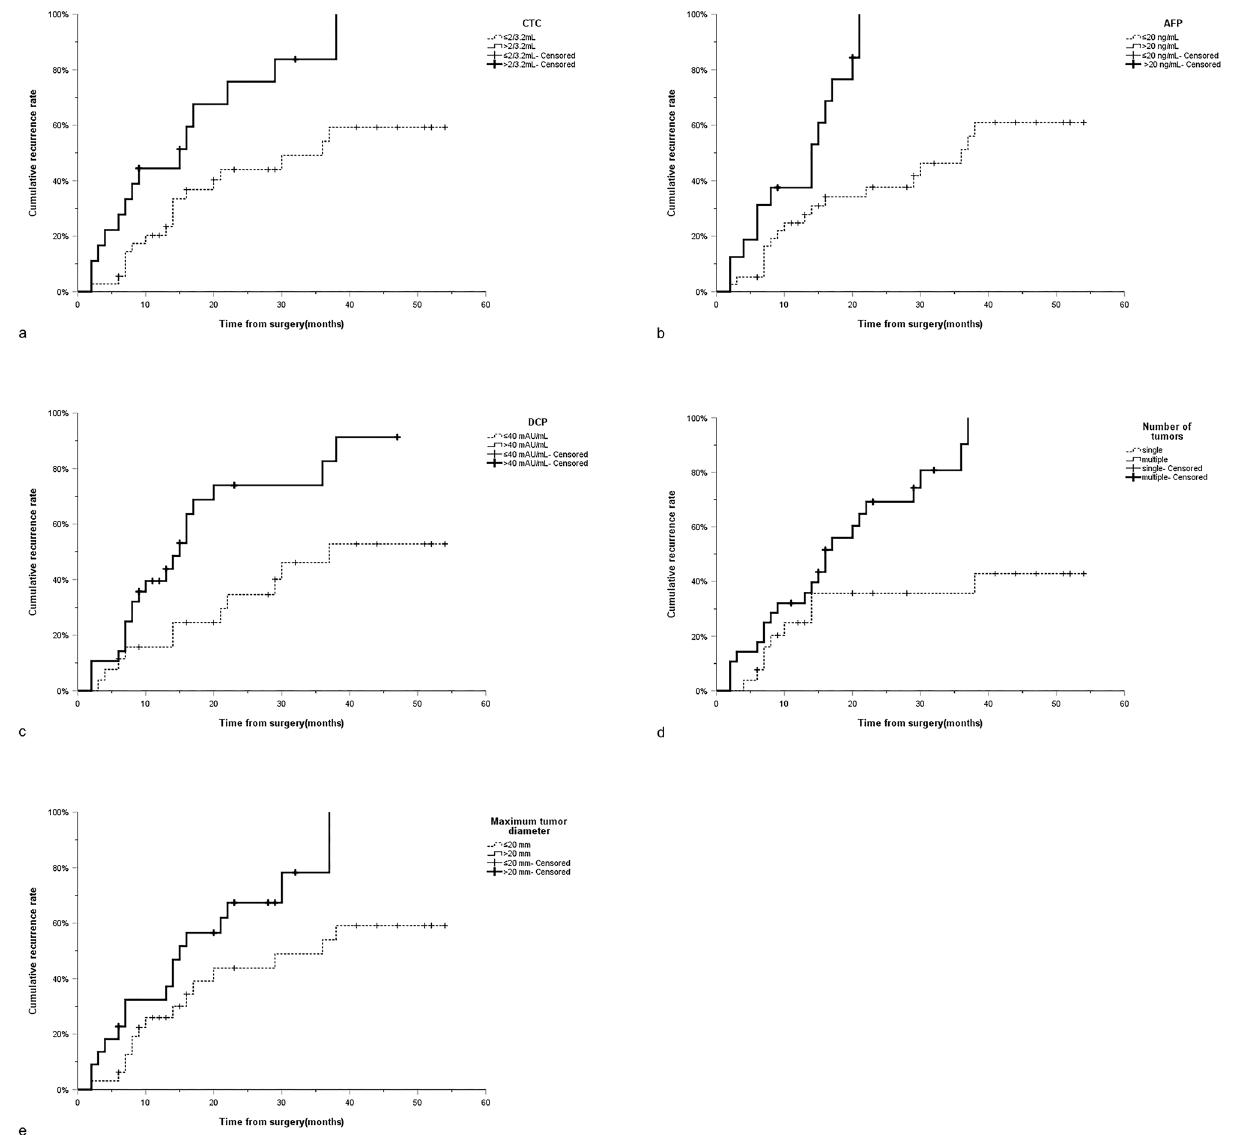
Figure 4. Curves of cumulative recurrence rate of RFA of HCC of ( a ) CTC, ( b ) AFP, ( c ) DCP, ( d ) number of tumors and ( e ) maximum tumor diameter in validation cohort. RFA Radiofrequency ablation; HCC Hepatocellular carcinoma; CTC Circulating tumor cells; AFP Alpha-fetoprotein; DCP Des-γ-carboxy